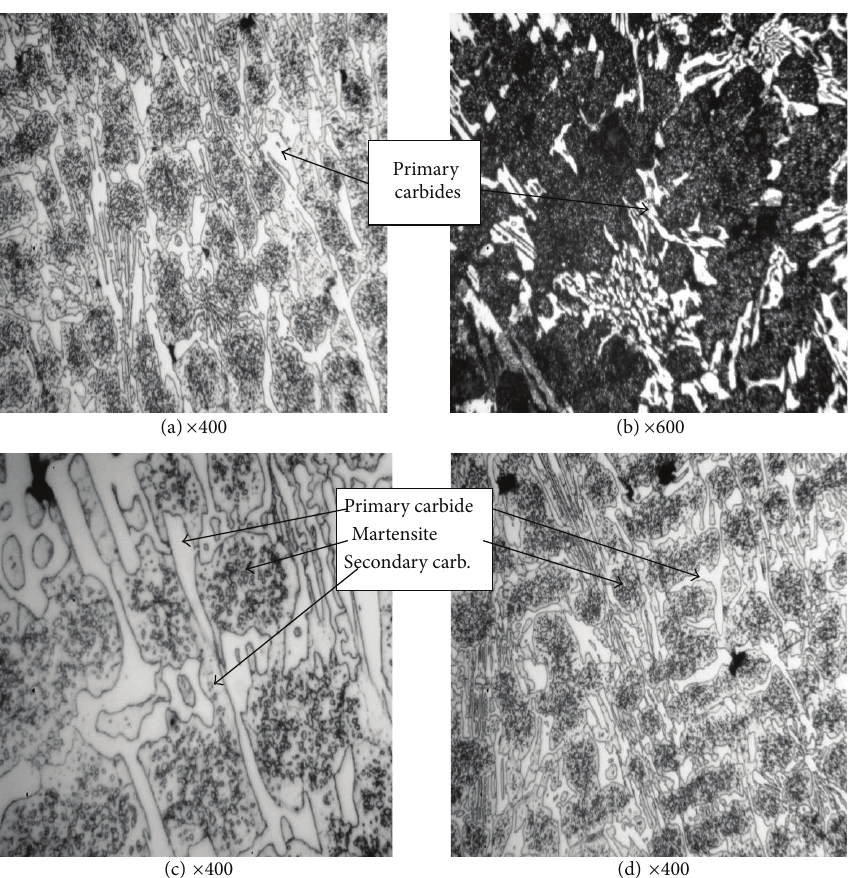
Figure 8: (a-b) Morphology of primary carbides in heat treated microstructures of experimental steel GS-4 and steel GS-5. (c-d) Appearance of quenched and tempered